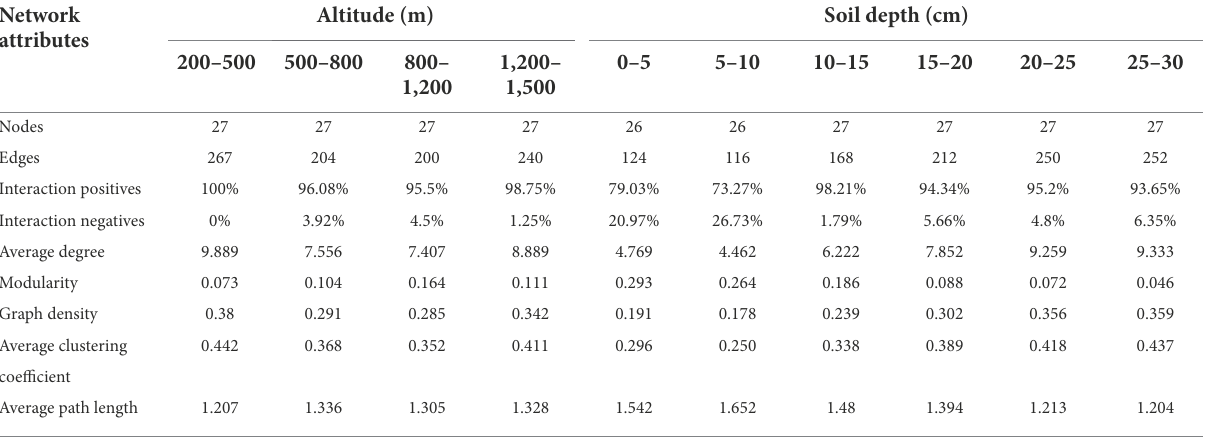
TABLE 2 Topological parameters of network analysis in different altitudes and soil depths. Network